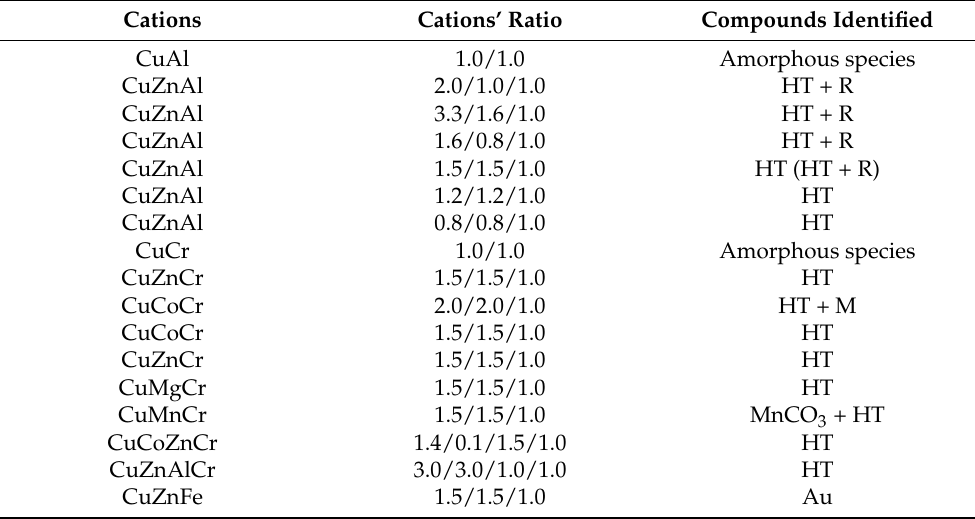
HT—hydrotalcite-like compounds; M—Cu 2 CO 3 (OH) 2 (malachite); R—(Cu,Zn) 2 CO 3 (OH) 2 (Rosasite);